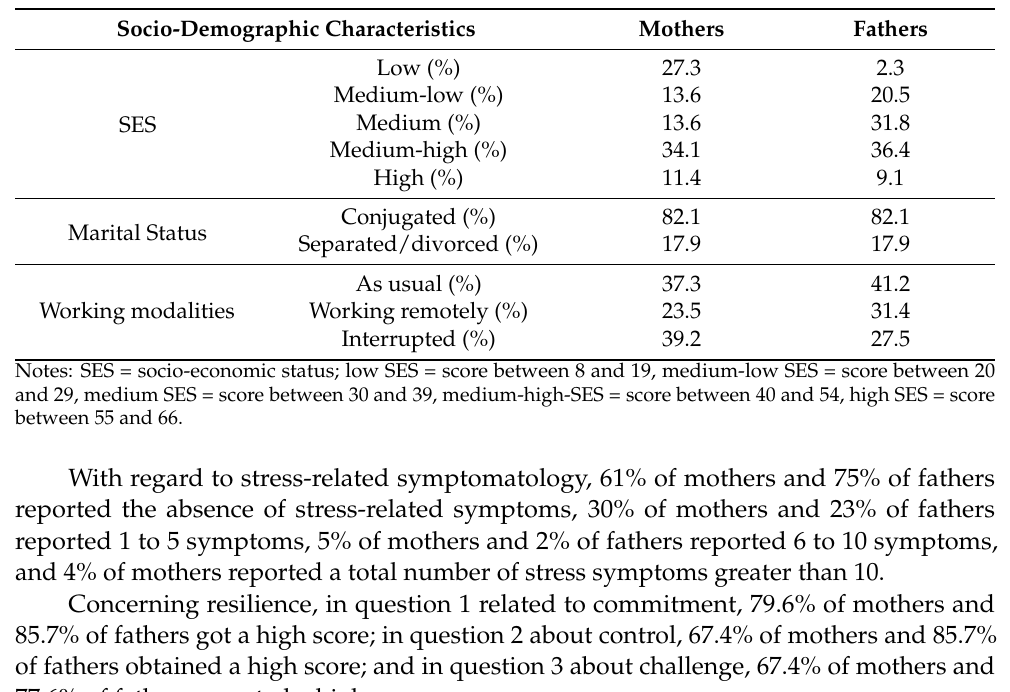
Table 2. Socio-demographic characteristics of parents at T0.